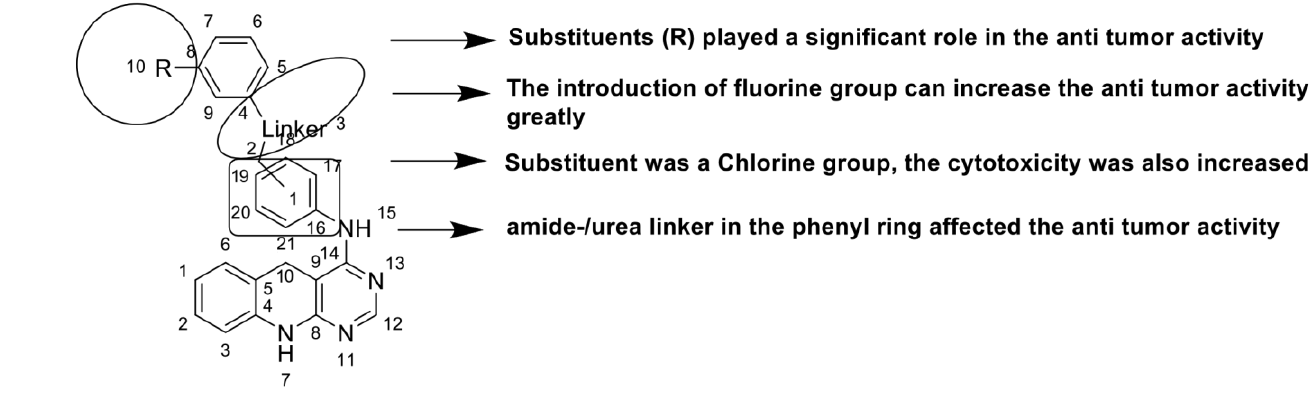
Figure 13. SAR of azaacridine derivatives as dual-target EGFR and Src kinase inhibitors. Table 15. Azaacridine as an anti-tumour agent.